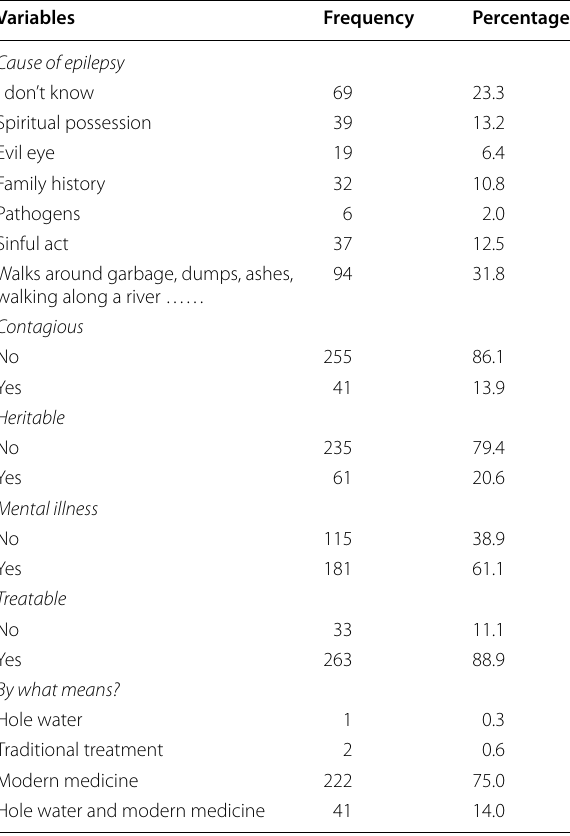
Table 3 Distribution of study subjects by (causal, contagion, heritability, treatability and mental illness belief) of people with epilepsy ( n 296) up at Ayder on- follow comprehensive = specialized hospital and Mekelle hospital, Mekelle,